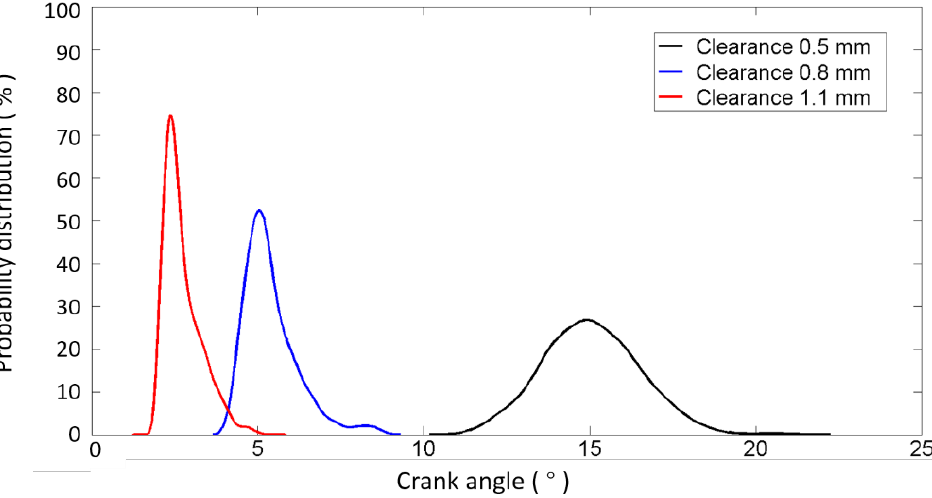
Figure 18. Probability distribution calculated by the presented method to identify the commencement of B1-cylinder exhaust valve closing impact in 480 combustion cycles with different clearances.